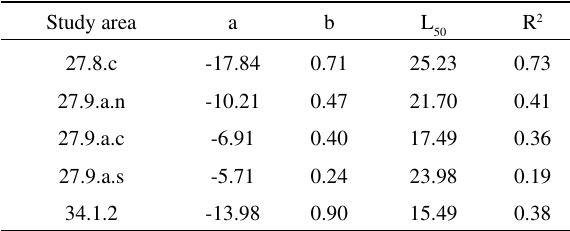
Table 3. – Parameters of maturity ogives obtained in each study area. 34.1.2, Canary Islands; 27.9.a.s, Gulf of Cadiz; 27.9.a.c, W Portuguese